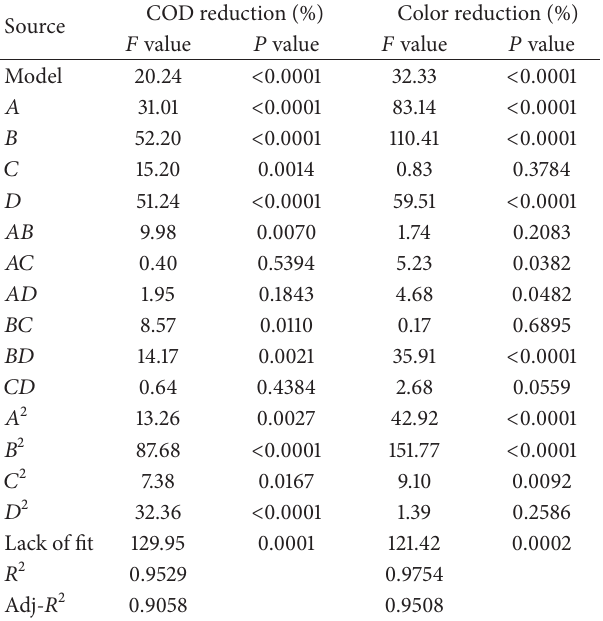
Table 5: ANOVA for